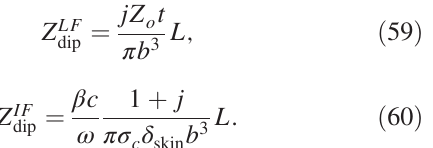
∈ ð 10 3 ; … ; 10 6 Þ S = m, c